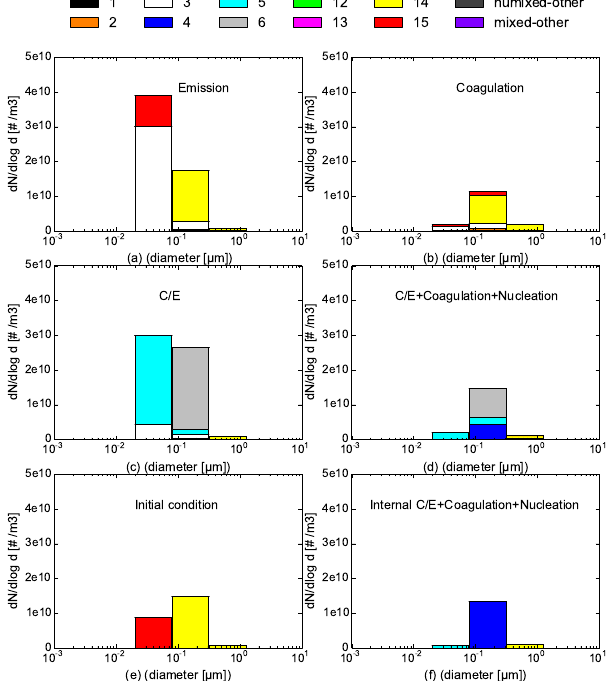
Figure 8. Result number distributions of externally mixed parti- cles as a function of particle diameter for the different chemical compositions for six different simulation scenarios: (a) emission only; (b) emission + coagulation; (c) emission + C / E; (d) emis- sion + coagulation + C / E + nucleation; (e) initial condition; (f) in- ternal mixing result.